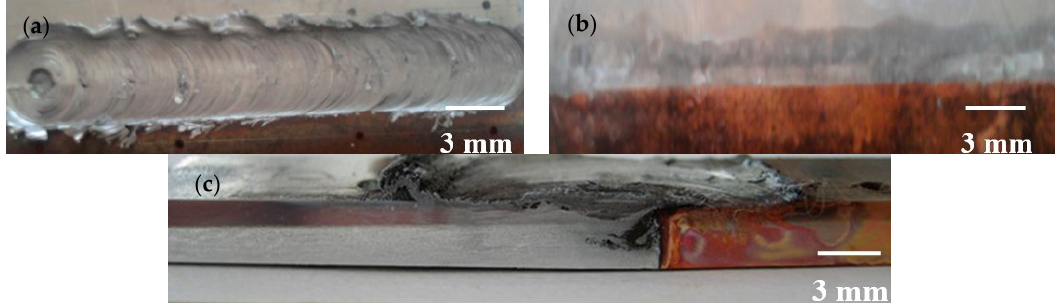
Figure 3. Macrograph of the welded part under 630/50/1 conditions: ( a ) Upper surface; ( b ) Lower surface; ( c ) Cross section.